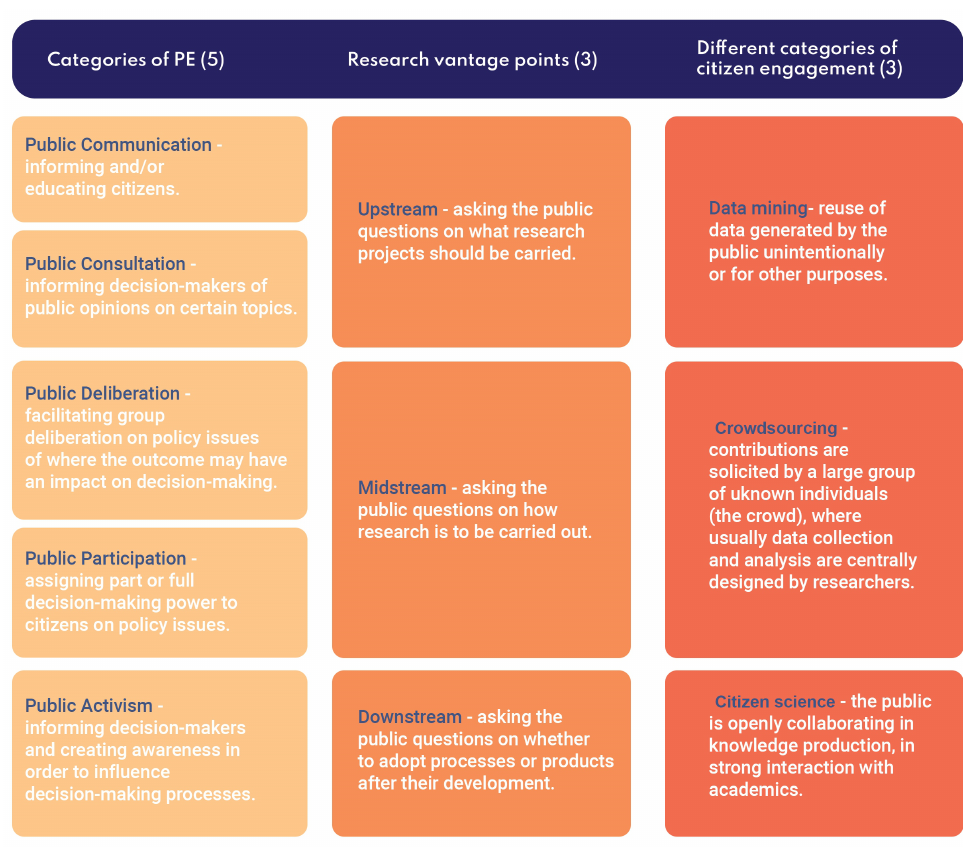
Figure 1. The multilayered nature of